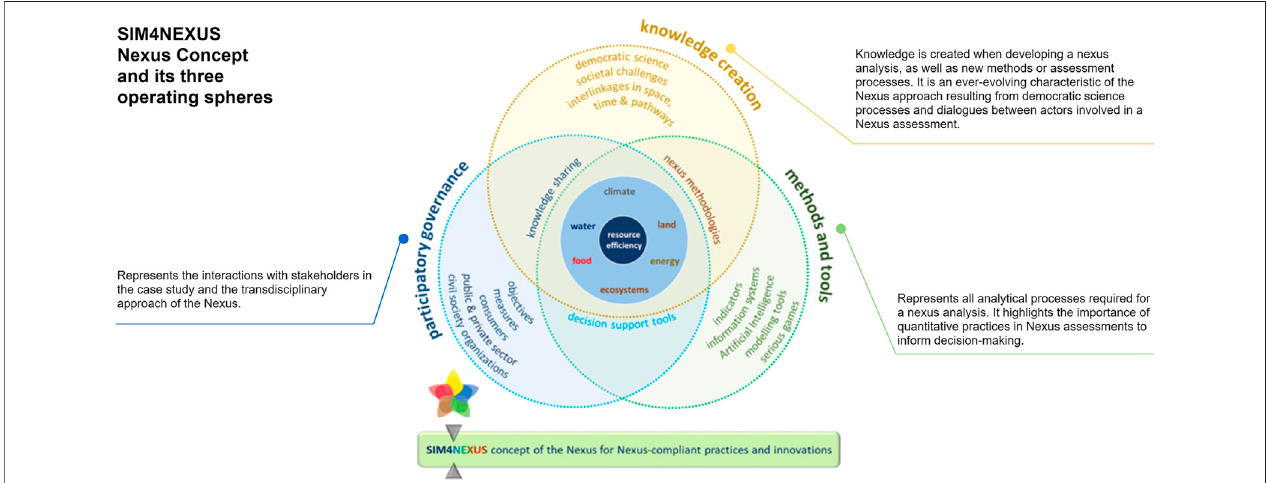
FIGURE 1 | Illustration of the Nexus concept from SIM4NEXUS Nexus (adapted from Ramos et al. (2020)).